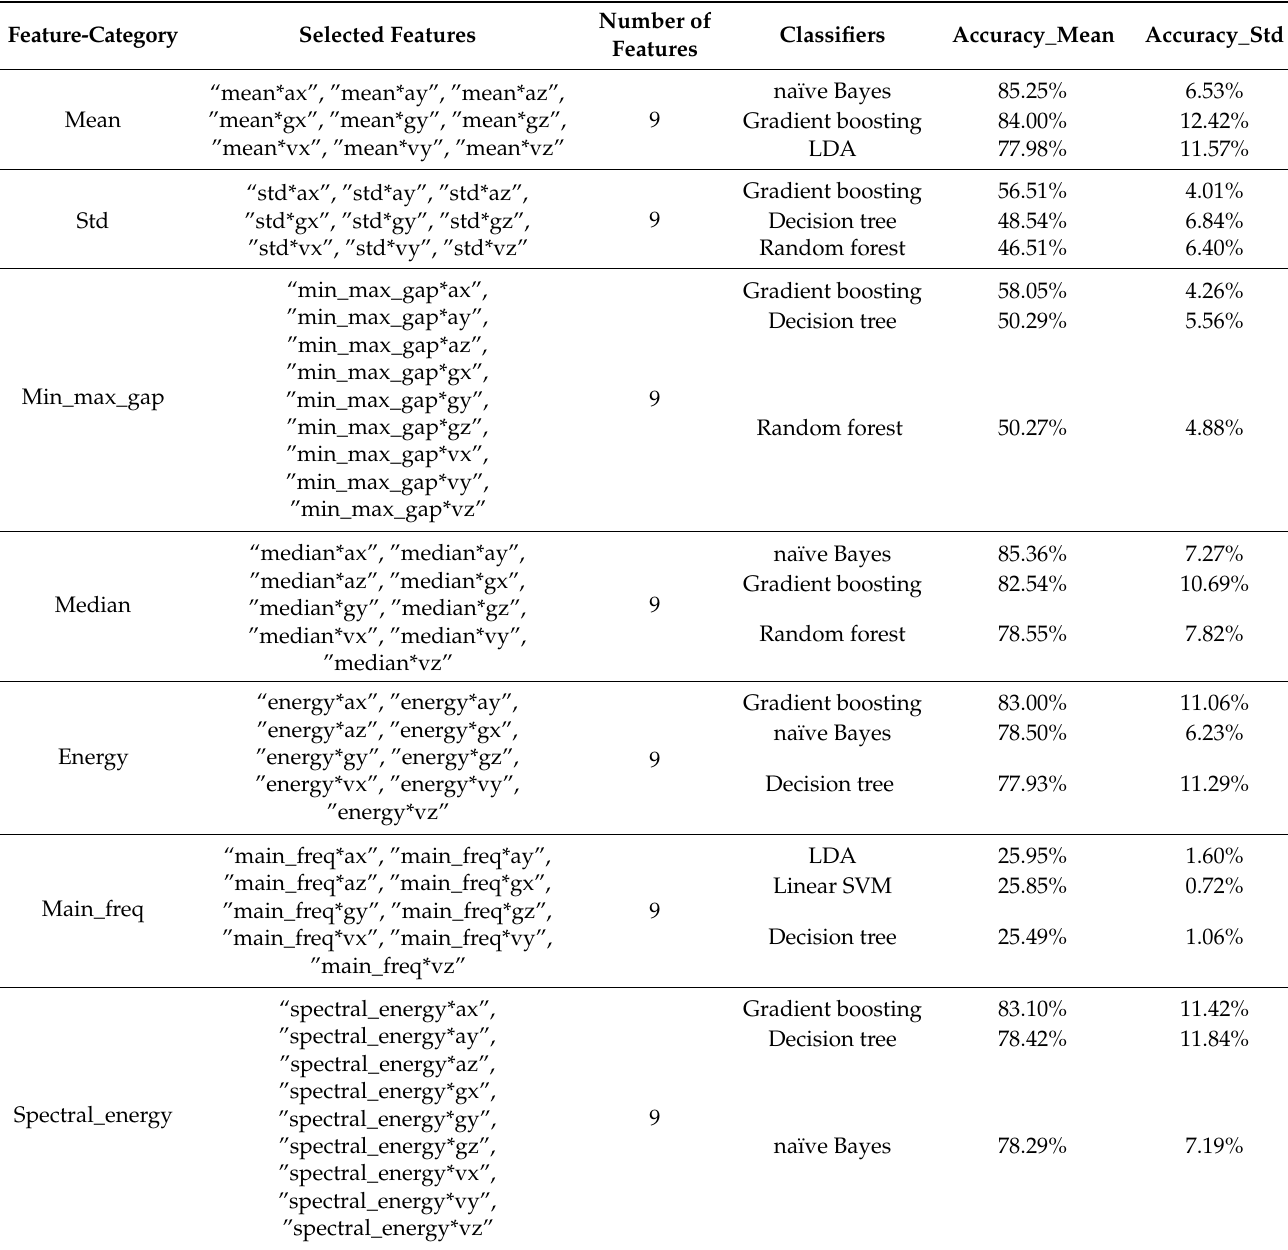
Table 9. Performance of feature-category based feature